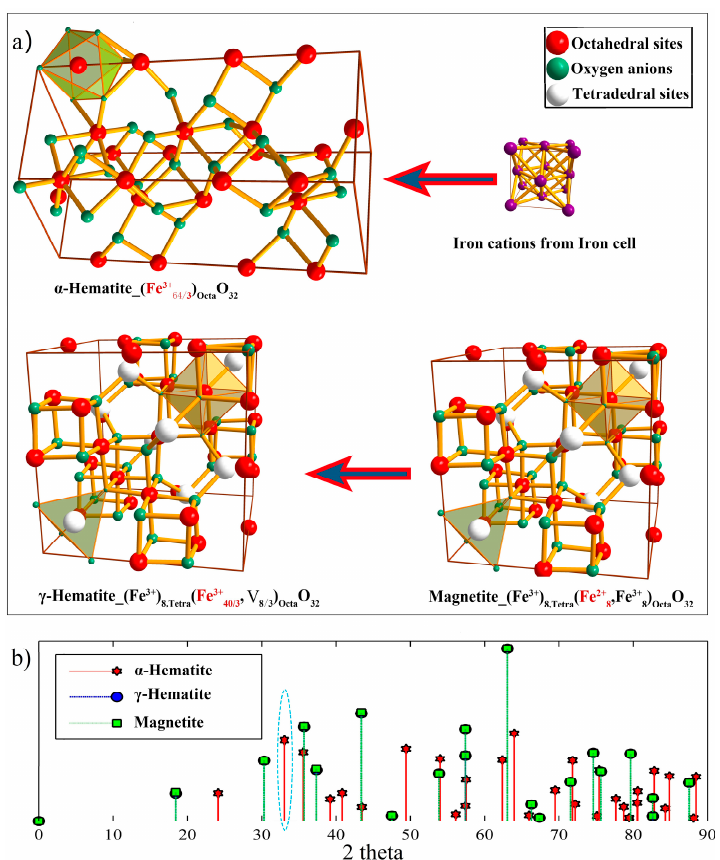
Figure 8. (a ) Unit cell structure and possible generation ways of the predominant α -hematite and the γ -hematite, and ( b ) the theoretically-calculated XRD patters for the two hematite and magnetite. Note that XRD patterns are theoretically calculated according to the software of Diamond 3 with Cu-Ka1 being a type of X-ray.